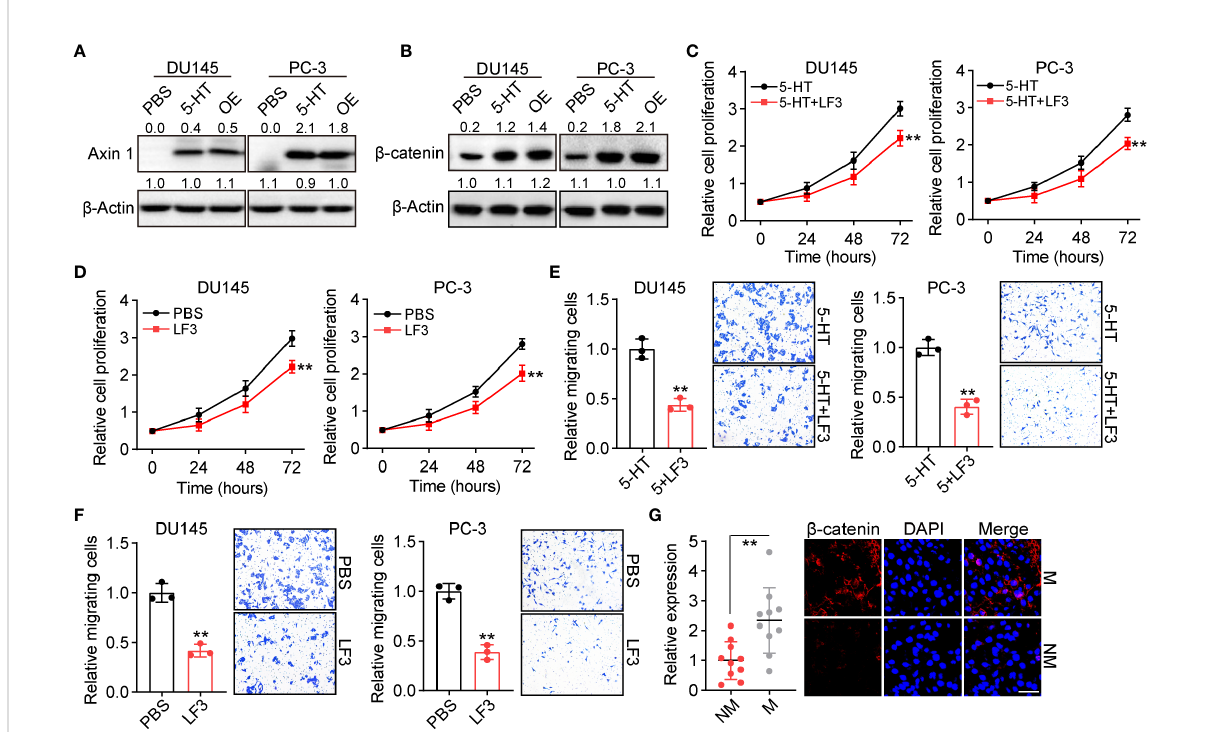
FIGURE 3 5-HT mediates Axin/ b -catenin activation in prostate cancer. (A) Western blotting of Axin 1 in DU145/PC-3 cells (treated with PBS or 5 m M 5-HT) and TPH1-overexpressing DU145/PC-3 cells. (B) Western blotting of b -catenin in DU145/PC-3 cells (treated with PBS or 5 m M 5-HT) and TPH1- overexpressing DU145/PC-3 cells. (C) Proliferation of DU145/PC-3 cells treated with 5-HT (5 m M) combined with LF3 (2 m M) or not. (D) Proliferation of TPH1-overexpressing DU145/PC-3 cells treated with PBS or LF3 (2 m M). (E) Relative number of migrating DU145/PC-3 cells treated with 5-HT (5 m M) combined with LF3 (2 m M) or not. (F) Relative number of migrating TPH1-overexpressing DU145/PC-3 cells treated with PBS or LF3 (2 m M). (G) Immuno fl uorescence staining of b -catenin in tumor tissues from patients with M and NM prostate cancer (n = 10 per group). The scale bar is 60 m m. ** p <